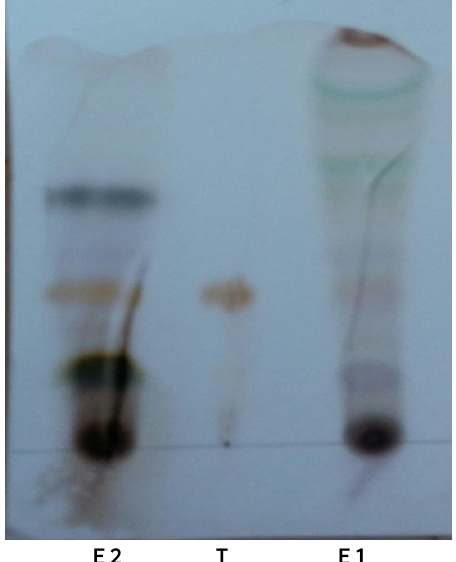
Figure(4): TLC for Agave americana leaves Figure (6): TLC for Agave americana leaves extract obtained by extraction methods No.1 extract obtained by extraction method No.1 and No.2 using silica gel GF as adsorbent and No.2 using silica gel GF as adsorbent 254 254 and (S ) as solvent system . Visualization by and (S ) as solvent system . Visualization by 1 3 Liebermann-Burcrhard spray reagent. Liebermann-Burcrhard spray